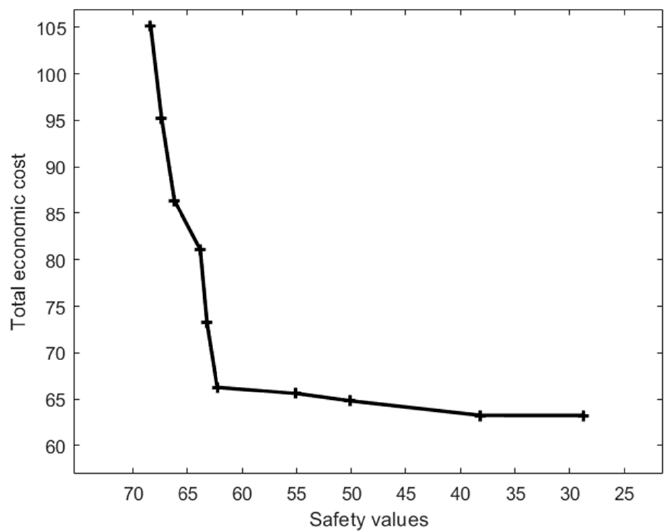
Figure 7. Plot of the optimal solution distribution under the dual objective. Table 5. Pareto optimal solution for the emergency center location.